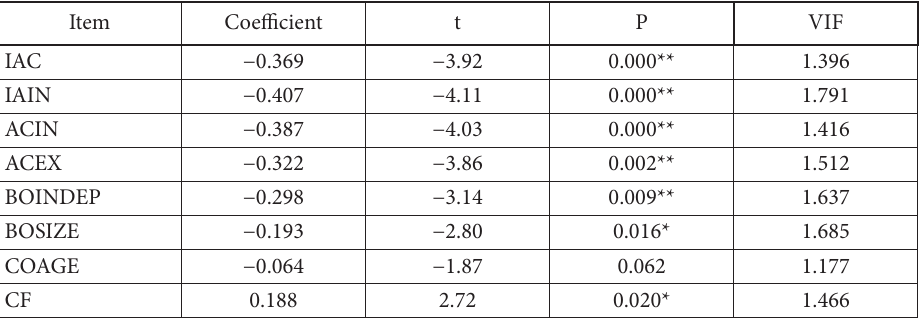
Table 3. Regression results of model 3 −